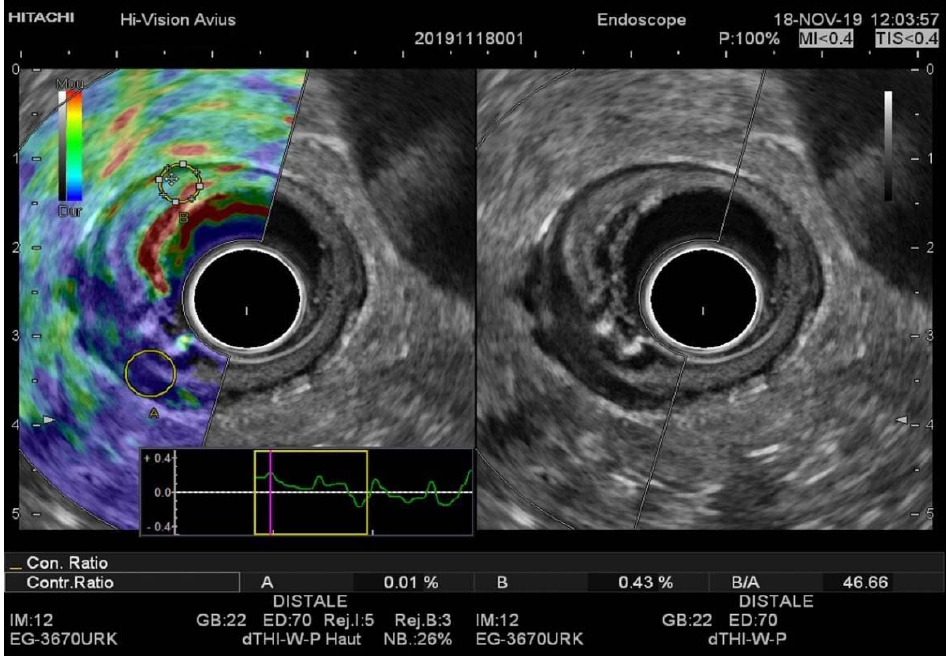
Figure 3. ( A ) EUS-RTE aspect in a 67-year-old female with pT3 rectal cancer. ( B ) EUS aspect of the same tumor. The tumor was classified as T3 with the cutoff value strain ratio (B/A) of 46.66. T3 was confirmed by histopathologic examination after surgical resection. RTE, real-time elastography.